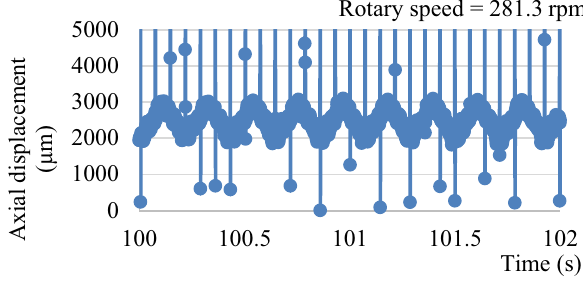
Fig. 21 Kick effects on rotary speed—kick region for Run_2